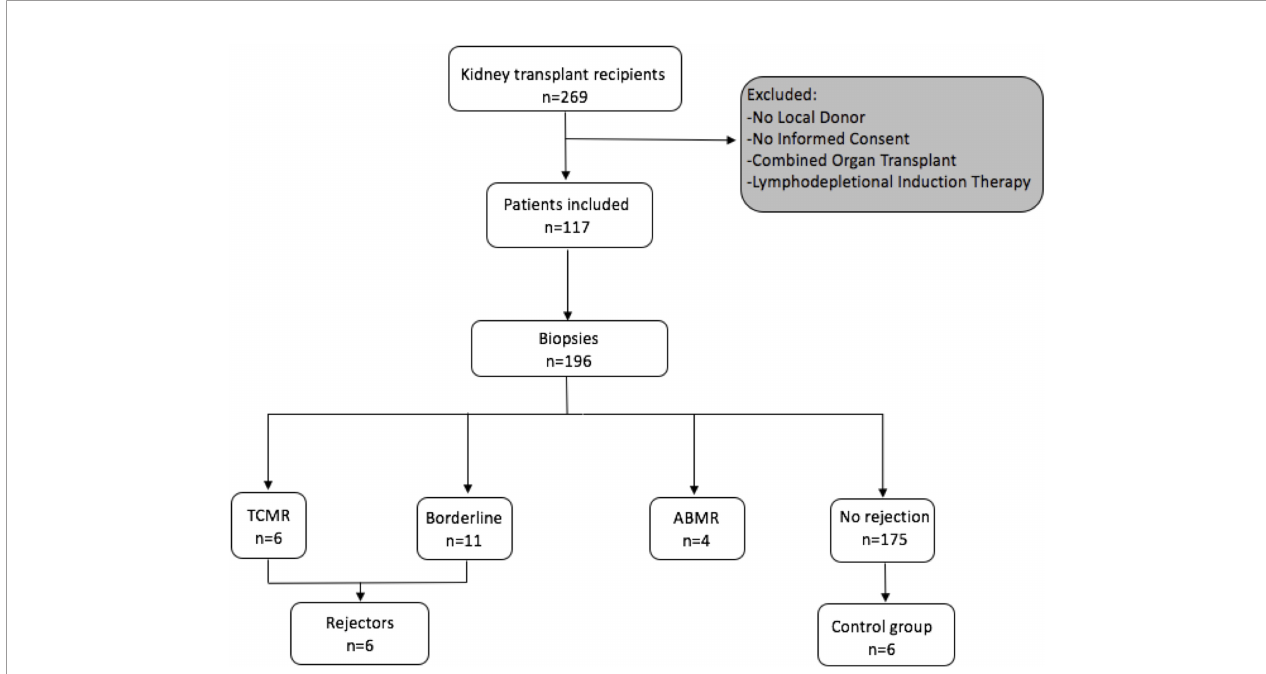
FIGURE 1 | Flowchart following the STROBE statement of number of patients included prospectively and consecutive PBMC sampling and incidence of rejection episodes in the observed